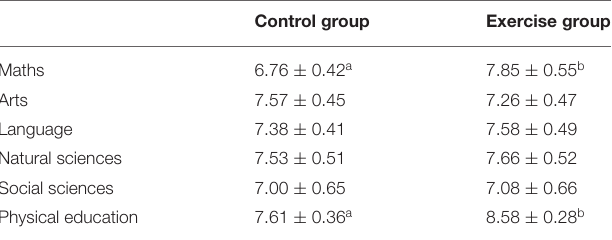
TABLE 6 | Academic qualifications from the control and exercise groups at the end of the semester. Control